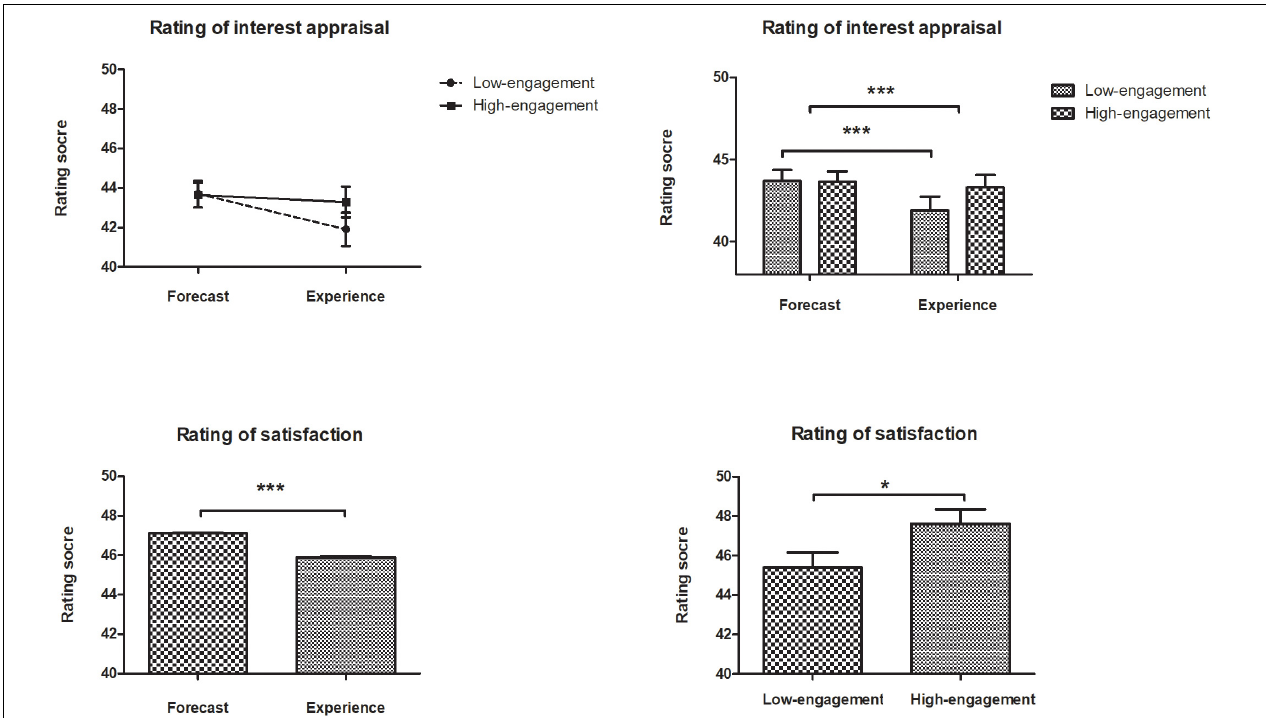
FIGURE 1 | Mean rating scores in the interest appraisal and satisfaction for participants in low-/high- engagement